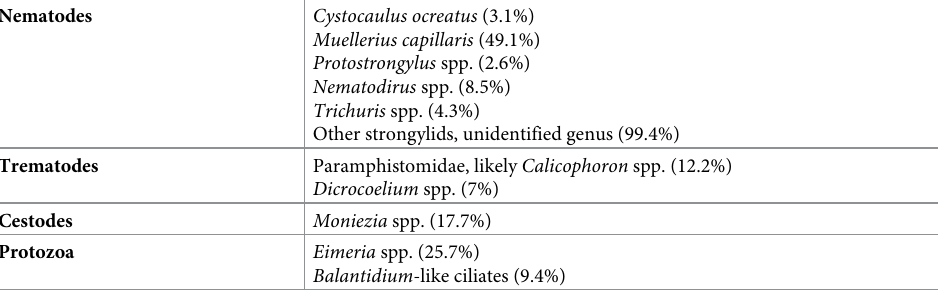
Table 1. Helminths and protozoa identified in the population of ‘ Fasciola -free’ sheep. Nematodes